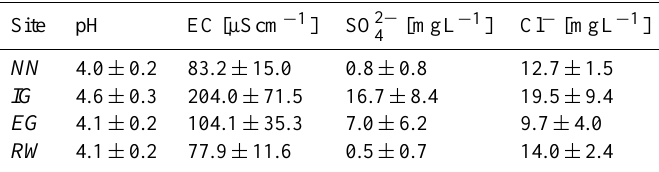
Table 3. pH-Values, electrical conductivity (EC) and concentration of sulfate (SO 2 − (means ± standard deviations).